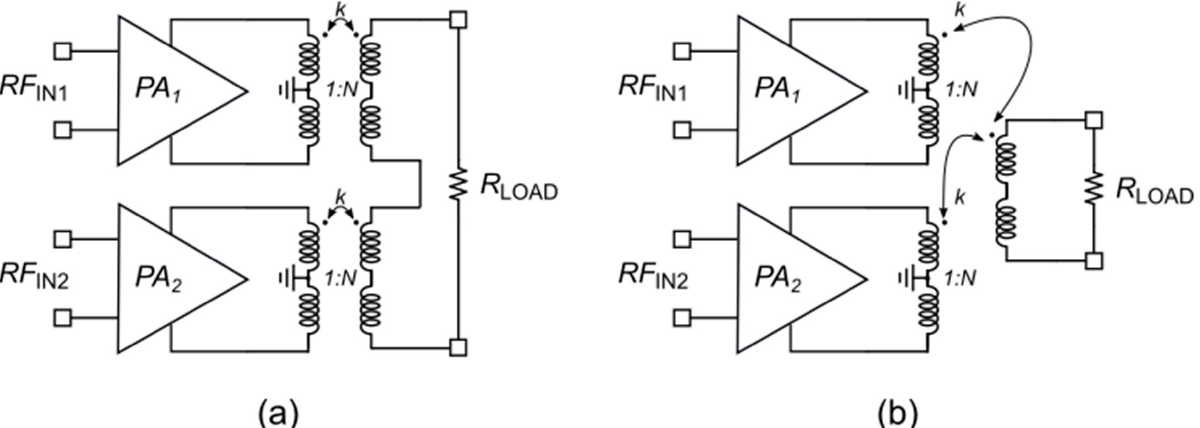
Figure 7. Power-combining techniques ( a ): voltage-combining (SCT), ( b ) current-combining (PCT).